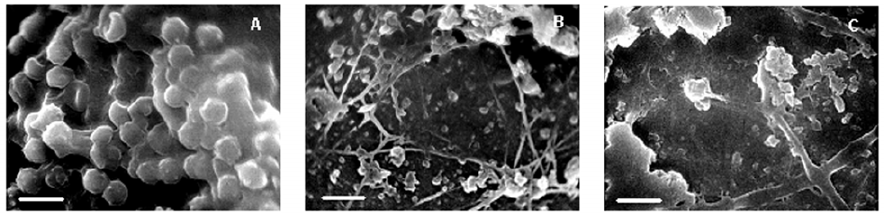
Figure 4. Scanning electron microscopy images of C.albicans biofilms formed invivo ( 6 2,000). ( A ) biofilms treated with heparinized saline; ( B ) biofilms after riccardin D treatment for 8 h. The inoculums of YEM 30 were removed after 4 hours growth, and riccardin D solution at the concentration of 64 m g/ml was injected into the catheter and locked in the lumen for 8 h; ( C ) biofilms after 5-day-treatment of riccardin D. The inoculums of YEM 30 were removed after 24 hours growth, and riccardin D solution at the concentration of 64 m g/ml was injected into the catheter and locked in the lumen for 8 h for 5 days consecutively. The bar is 15 m m for the three panels.